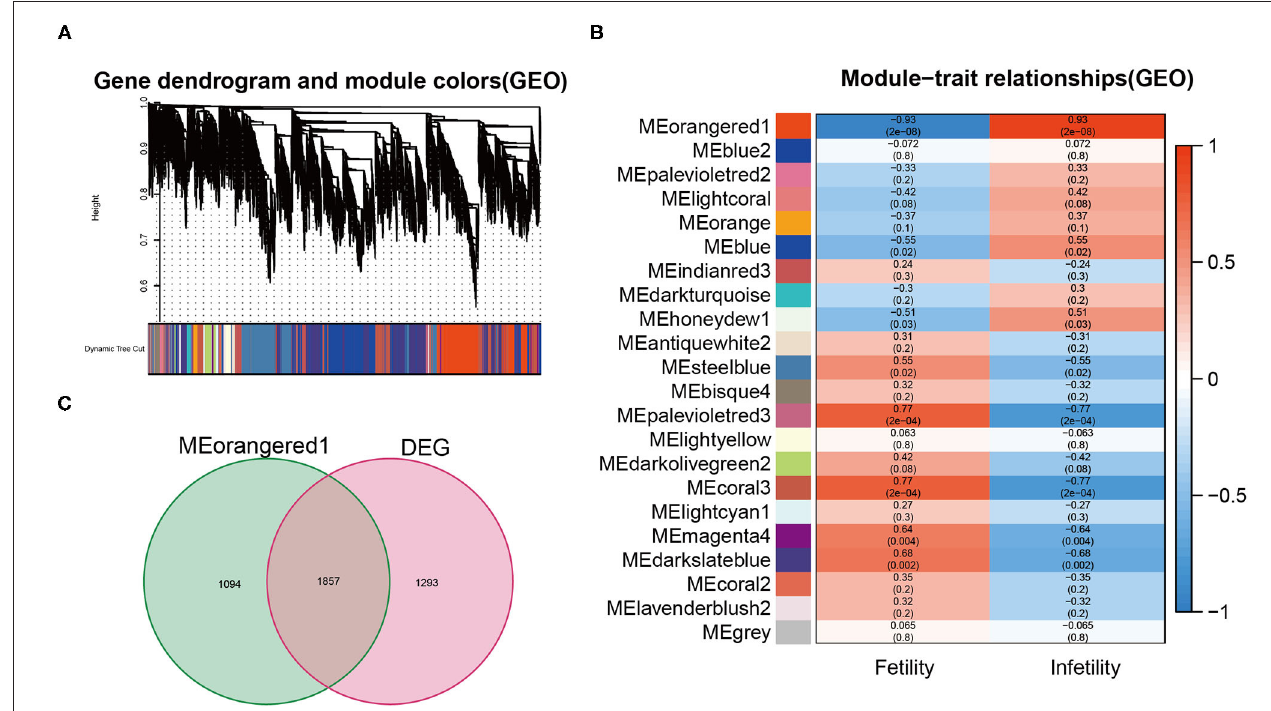
FIGURE 2 | (A) The cluster dendrogram of co-expression genes in infertile endometriosis. (B) Module–trait relationships in infertile endometriosis. (C) The intersection genes between DEG and the orangered1